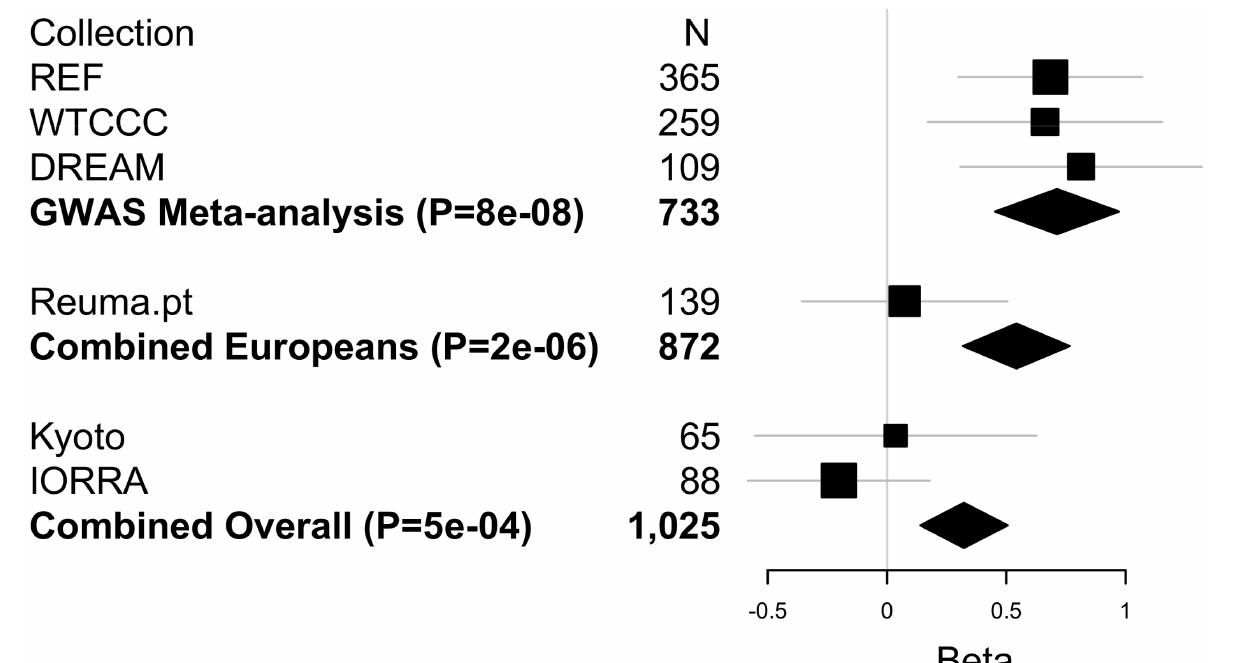
Figure 5. Replication and overall results for the CD84 SNP rs6427528. Forest plot shows each cohort, sample size and linear regression beta coefficient estimates with symbol size proportional to cohort sample size and thin horizontal lines showing beta 95% CIs. Inverse variance weighted meta-analysis results are shown in bold for GWAS, GWAS + European (Portuguese) replication samples, and for GWAS + European + Asian (Japanese) replication samples, with diamond widths indicating beta 95% CIs.